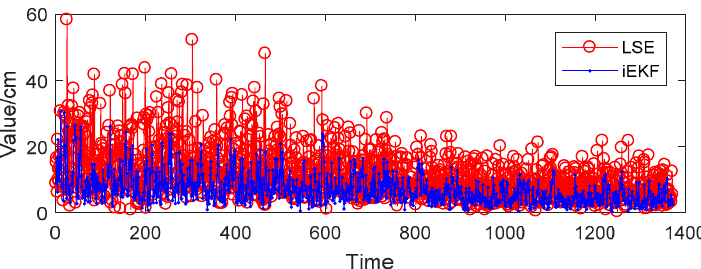
Figure 6. Deviation performances of the two algorithms for head tag.